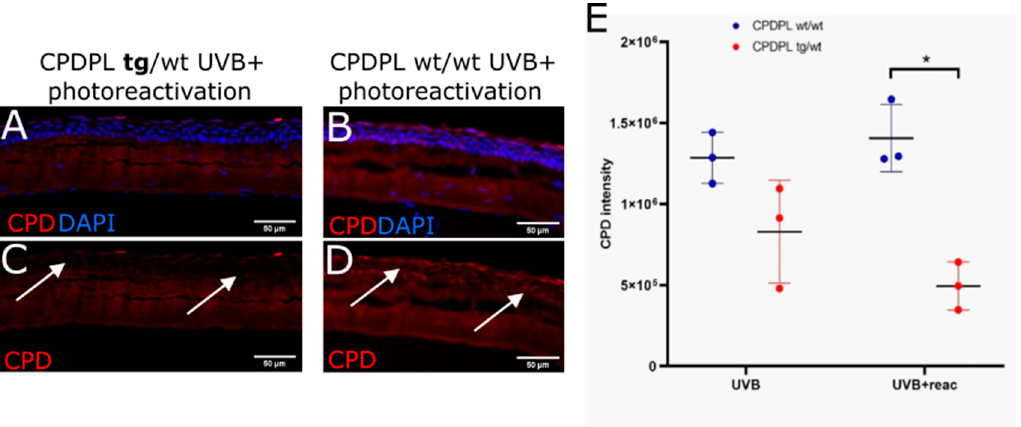
Figure 5. K14 stain of a K14-CPD-PL mouse cornea section, showing clear K14 expression in the epithelial basal layer in the central cornea and expression across the full thickness of the epithelium in the limbus. The bright signal shown at the limbus (arrows) demonstrates high presence of K14.